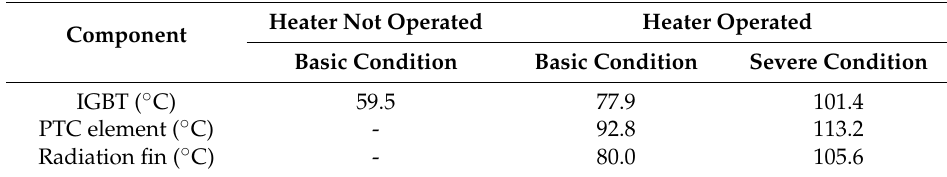
Table 6. Results of the heat flow analysis of the controller-integrated high-voltage PTC heating